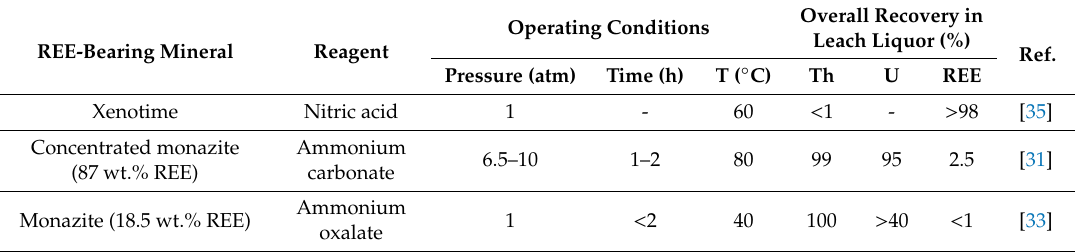
Table 2. Uranium and thorium separation from REE by a two-step cracking-leaching process.